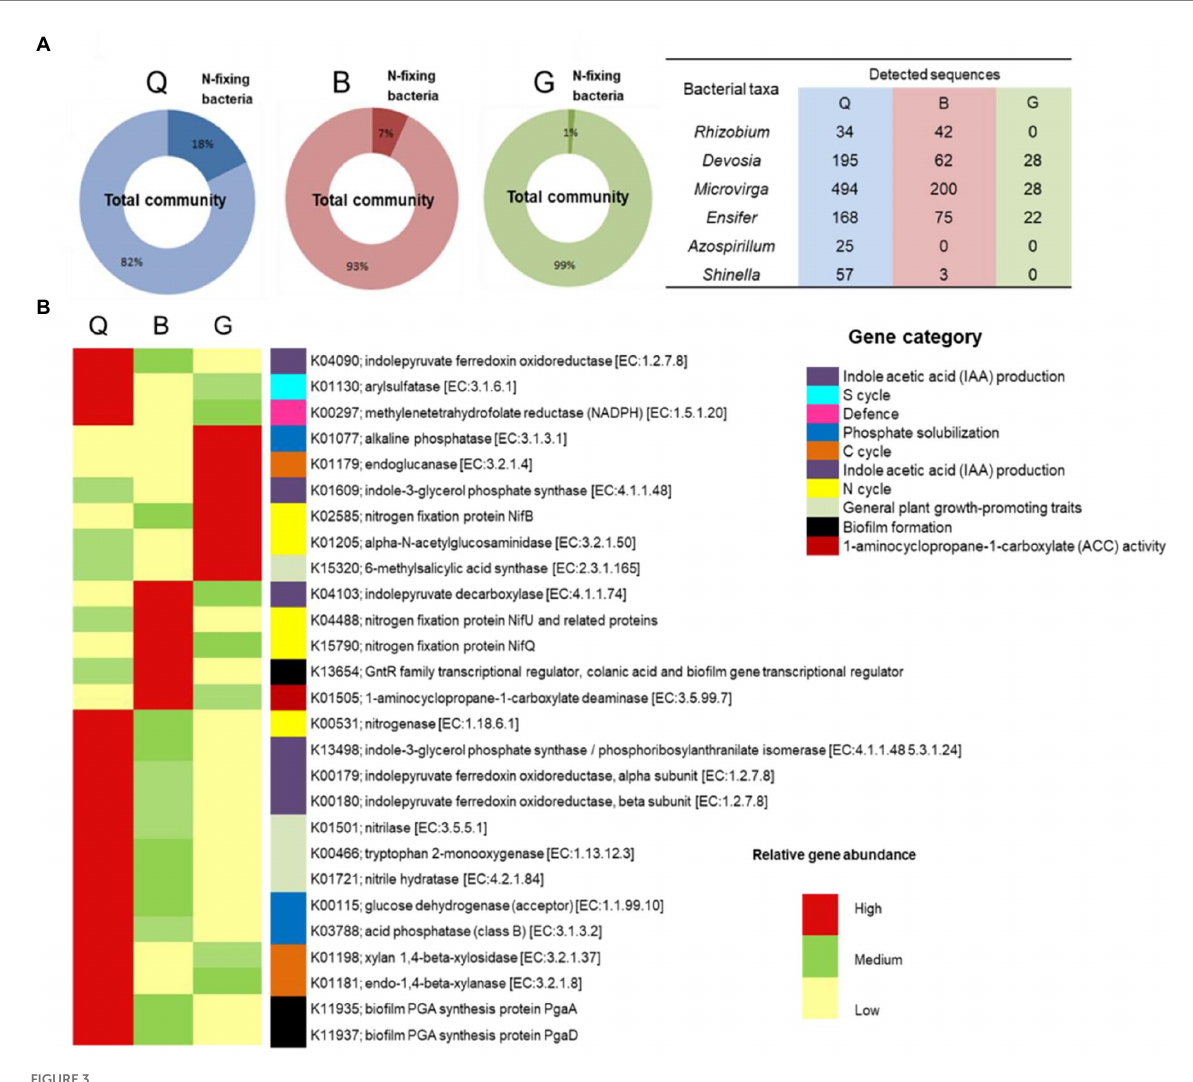
FIGURE 3 (A) Identification and relative sequence abundance of potential N-fixing bacteria present in each soil type. (B) The heat map of relative abundance of metabolic functional profiles of Kyoto Encyclopedia of Genes and Genomes (KEGG) orthologs (KOs) assigned to KEGG pathways involved in plant health, fitness, and growth, as well as the nutrient cycle in the three soil types. G; Giza location, Q; Al-Qalyubia location, and B; Beni-Suef